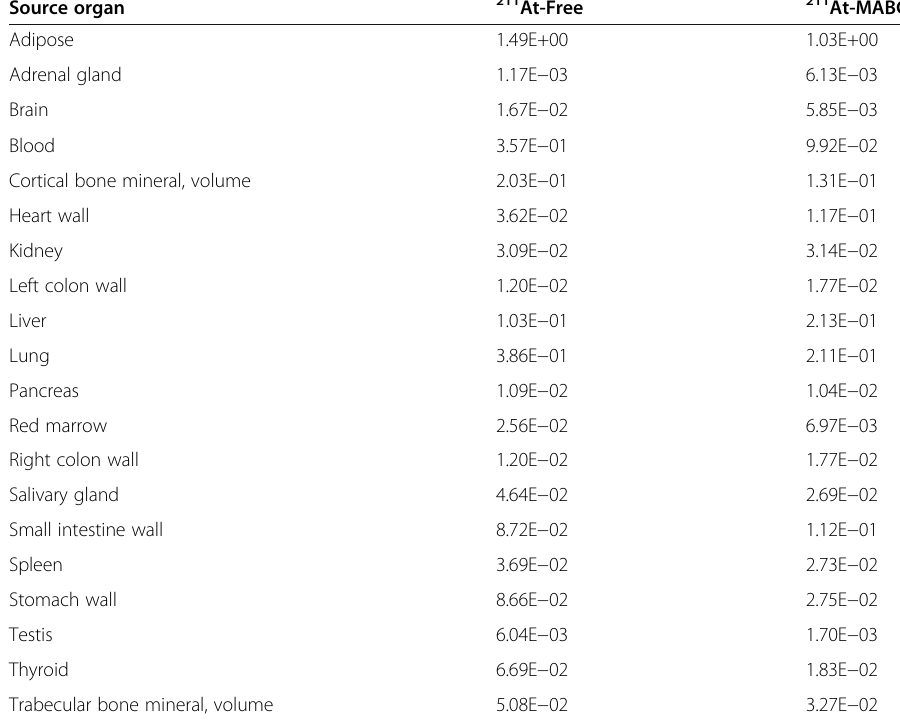
Table 3 Time-integrated activity coefficient (Bq-h/Bq) for input to IDAC-Dose 2.1 for adult male model calculated using OLINDA/EXM version 1.1 for free 211 At and 211 At-MABG in the main target organs. It was calculated by extrapolation from the distribution data of mice Source organ 211 At-Free